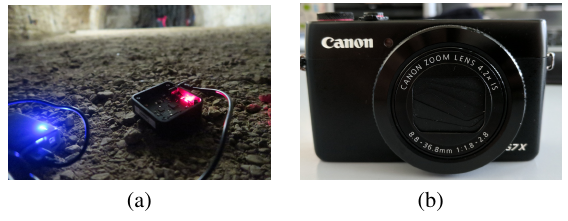
Figure 2. (a) UWB Pozyx device powered by a standard power- bank. (b) Canon G7X camera.